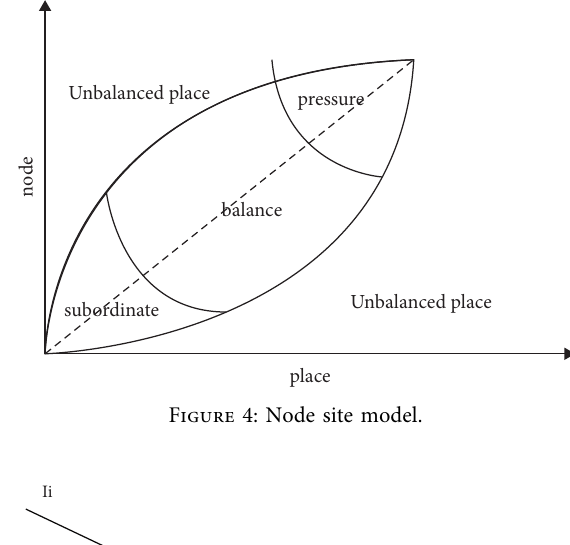
Figure 4: Node site model.